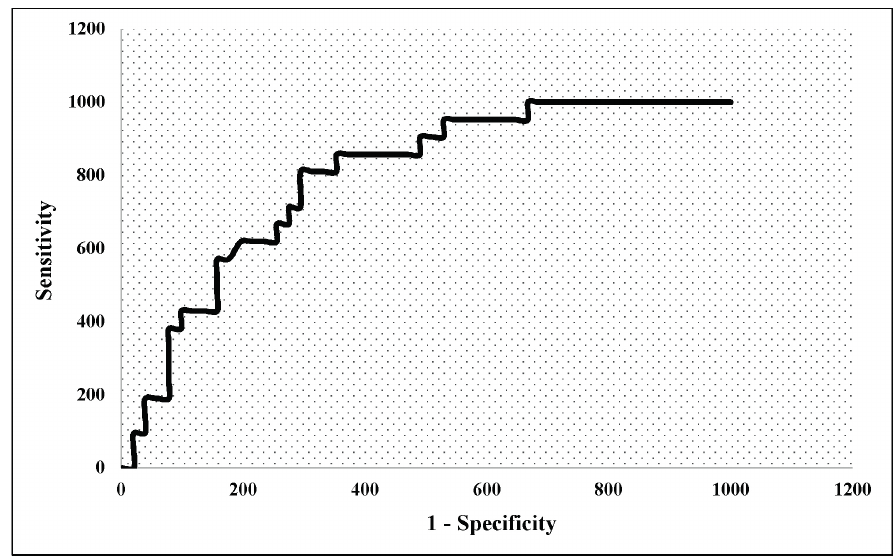
Figure 3 - ROC curve belongs to total thiol values in fitness group is depicted. Area under the curve (AUC): 0.793, Sensitivity: 0.85, Specificity:0.65, 95% Confidence Interval (CI) lower border:0.687, 95% Confidence Interval upper border:0.899.